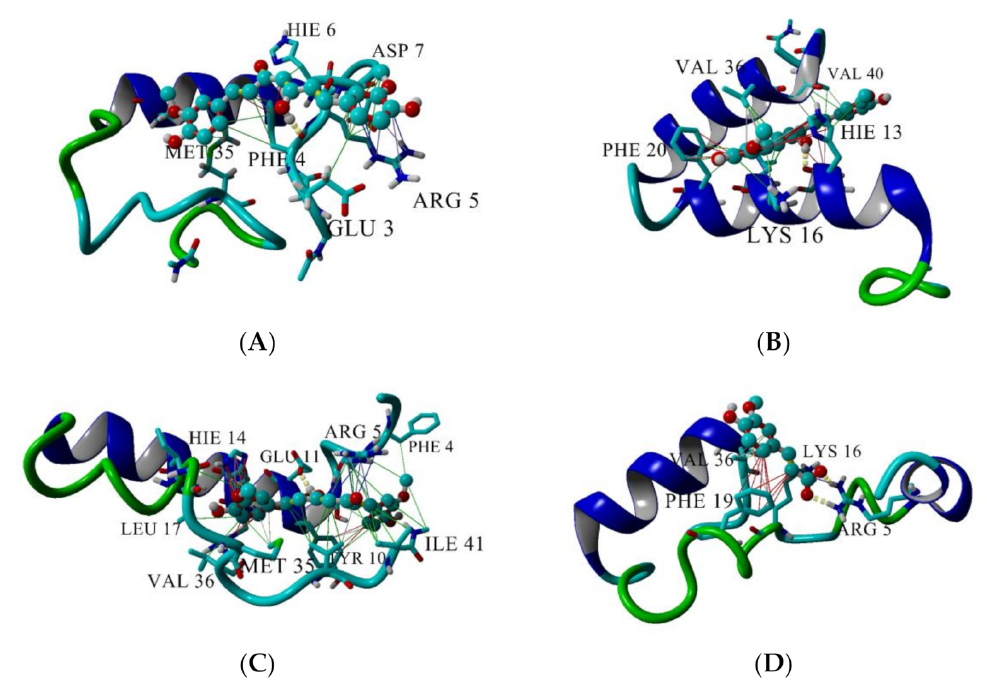
Figure 9. Interactions between CU and A β peptide ( A – C ) and between FA and A β peptide ( D ). The peptide is given in cartoon, the ligand–in ball-and-stick. Hydrogen bonds are given by yellow dashes, hydrophobic interactions–by green lines, π - π interactions–by red lines and cation- π interaction–by blue lines. Interactions are visualized by YASARA